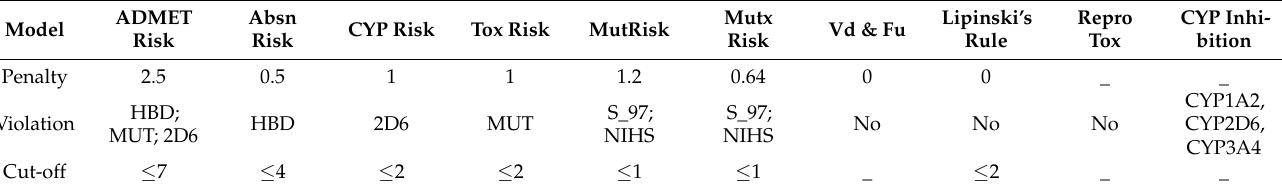
Table 5. ADMET Predictor™ analysis for the SBL-1